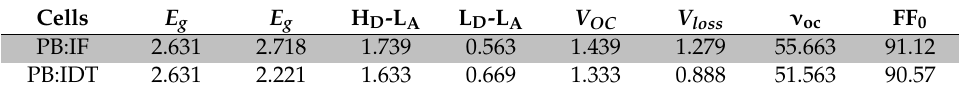
Table 6. Calculated energy gaps E g of donor (eV), optical bandgap E g of the active layer (eV), di ff erence between the HOMO of the donor and the LUMO of the acceptor H D –L A (eV), di ff erence between the LUMO of the donor and the LUMO of the acceptor L D –L A (eV), the open-circuit voltage V OC (V), voltage loss V loss (V), and fill factor in the ideal state FF 0 (%) of two polymer solar cells (PSCs) (PB:IF